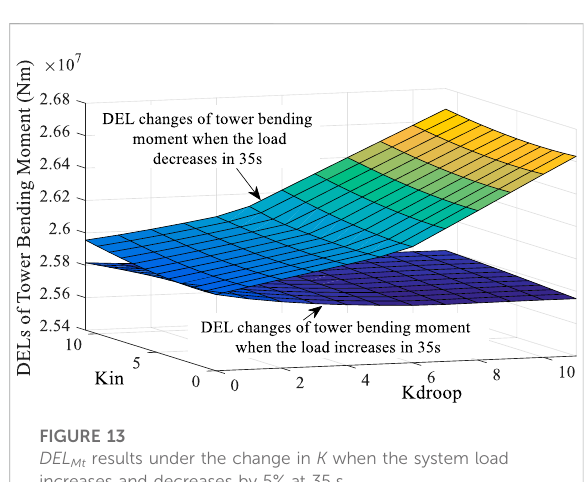
FIGURE 12 DEL Ms results under the change in K when the system load increases and decreases by 5% at 35 s.